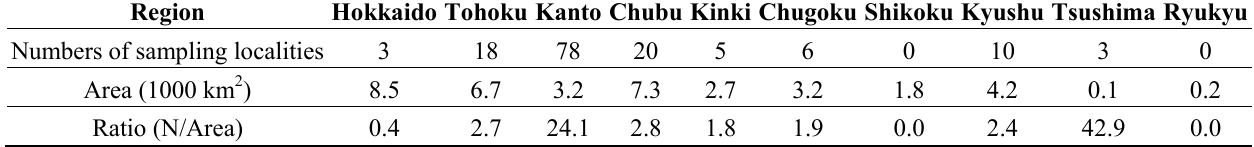
Table 3. Data set used for species assembly analysis of